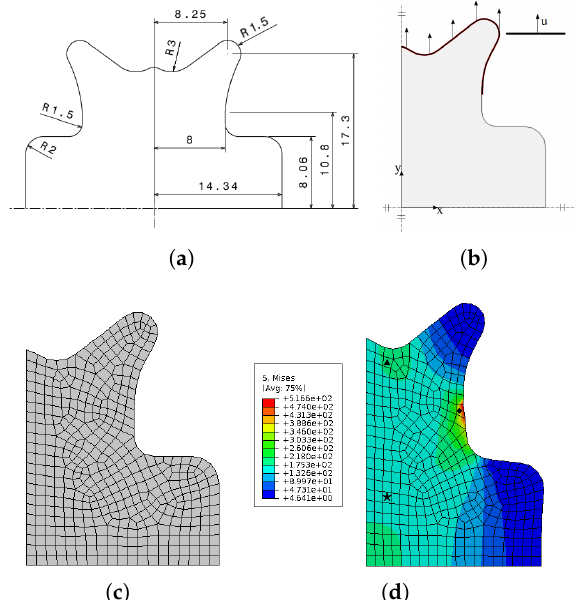
Figure 17. Adapted butterfly specimen [22,68]: ( a ) CAD geometry (in mm), ( b ) loading conditions, ( c ) numerical mesh and ( d ) the von Mises equivalent stress distribution obtained at the end of the test using the ANN model. Localization of the selected point for